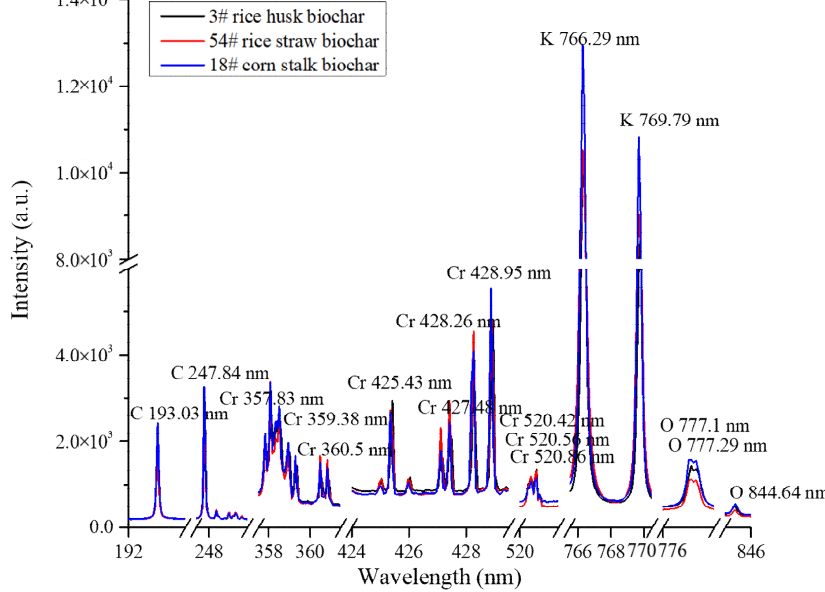
Figure 1. SEM ( a ) and EDS ( b ) analysis of biochar.